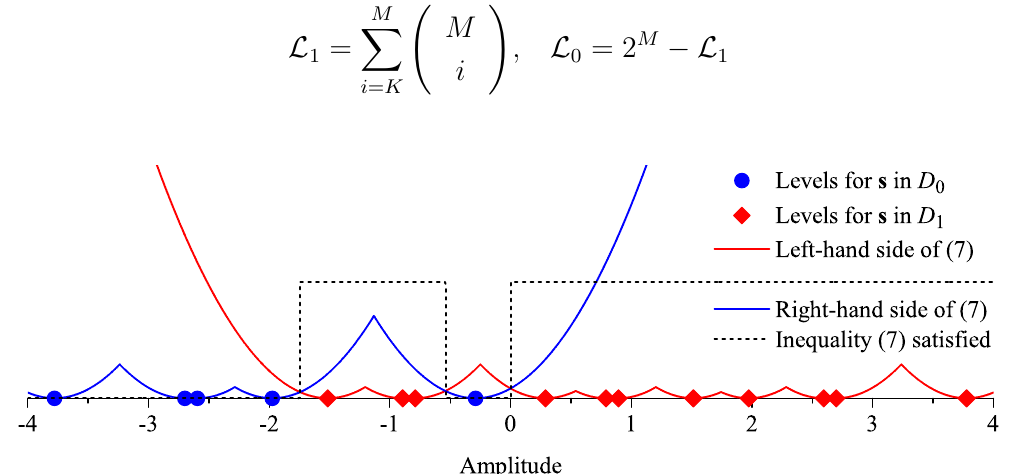
Figure 1. A realization of the received symbols (or levels), the likelihood functions and decision regions. Real valued channel gains are